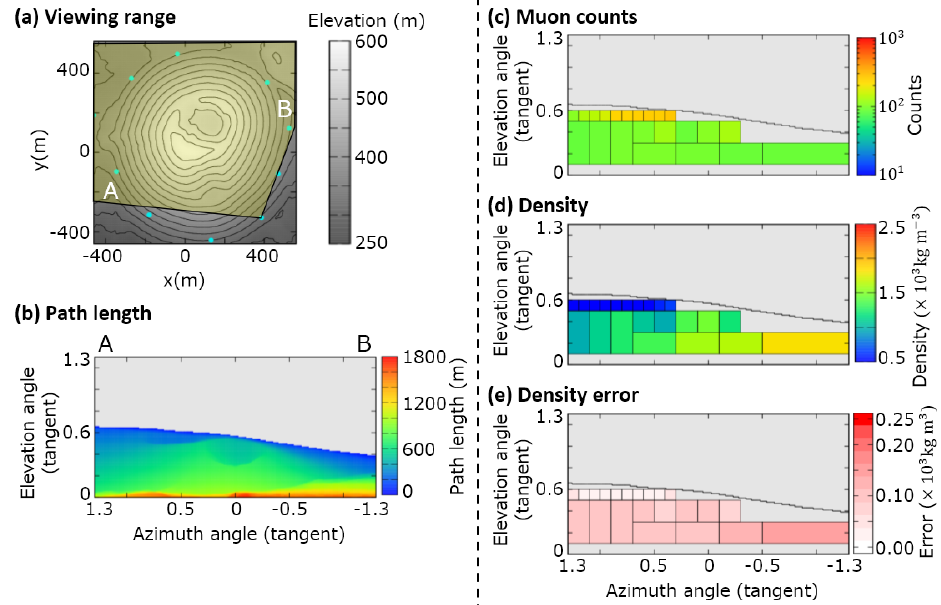
Figure B6. Observation site SE. (a) Map, topography, and viewing range; (b) path length of the volcanic cone; (c) muon counts N obs (d) density ρ i . The maximum value of the color bar indicates a density of > 2 . 5 × 10 3 kgm − 3 and the minimum value is < 0 . 5 × 10 3 kgm − 3 . (cid:16) (cid:17) − ρ low ρ up / 2. The maximum value of the color bar indicates a density error of > 0 . 25 × 10 3 kgm − 3 . (e) Density error (cid:49)ρ = i i